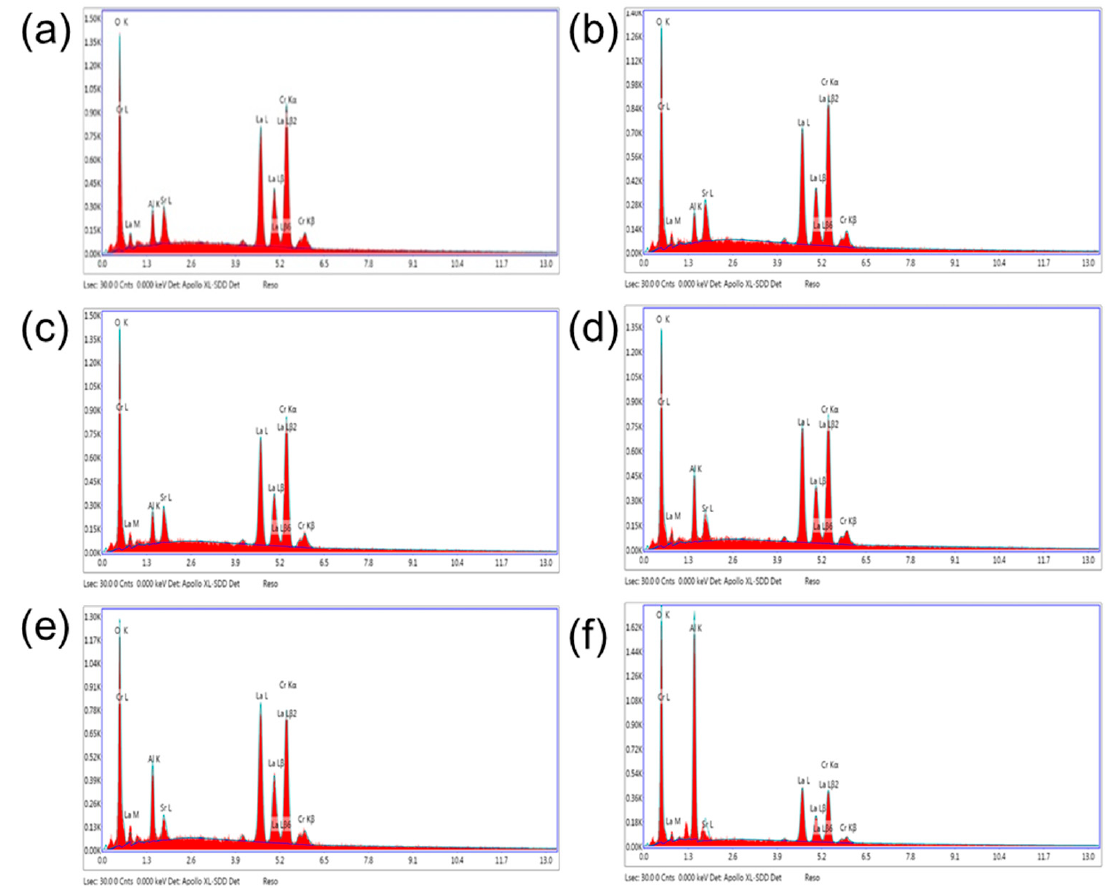
Figure 4. EDS results of 0.2LSCO thin films annealed at different temperatures for 1 h: ( a ) 800 ◦ C; ( b ) 900 ◦ C; ( c ) 1000 ◦ C;